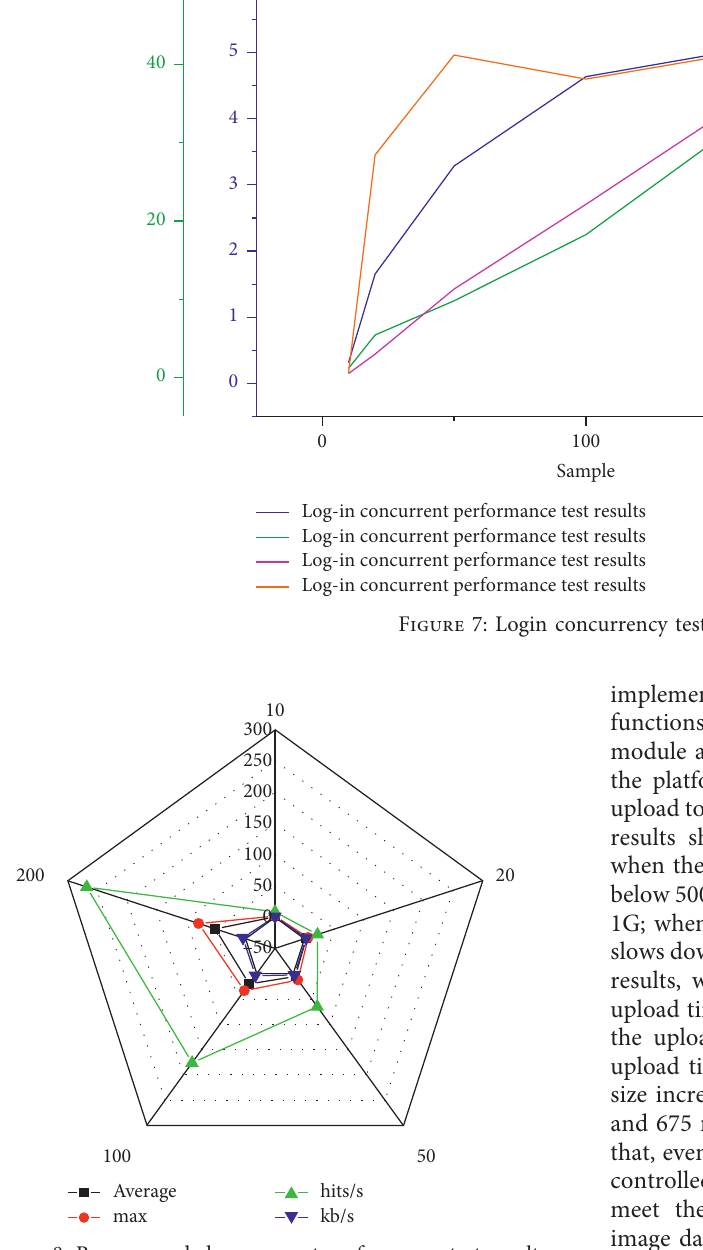
Figure 8: Recommended concurrent performance test